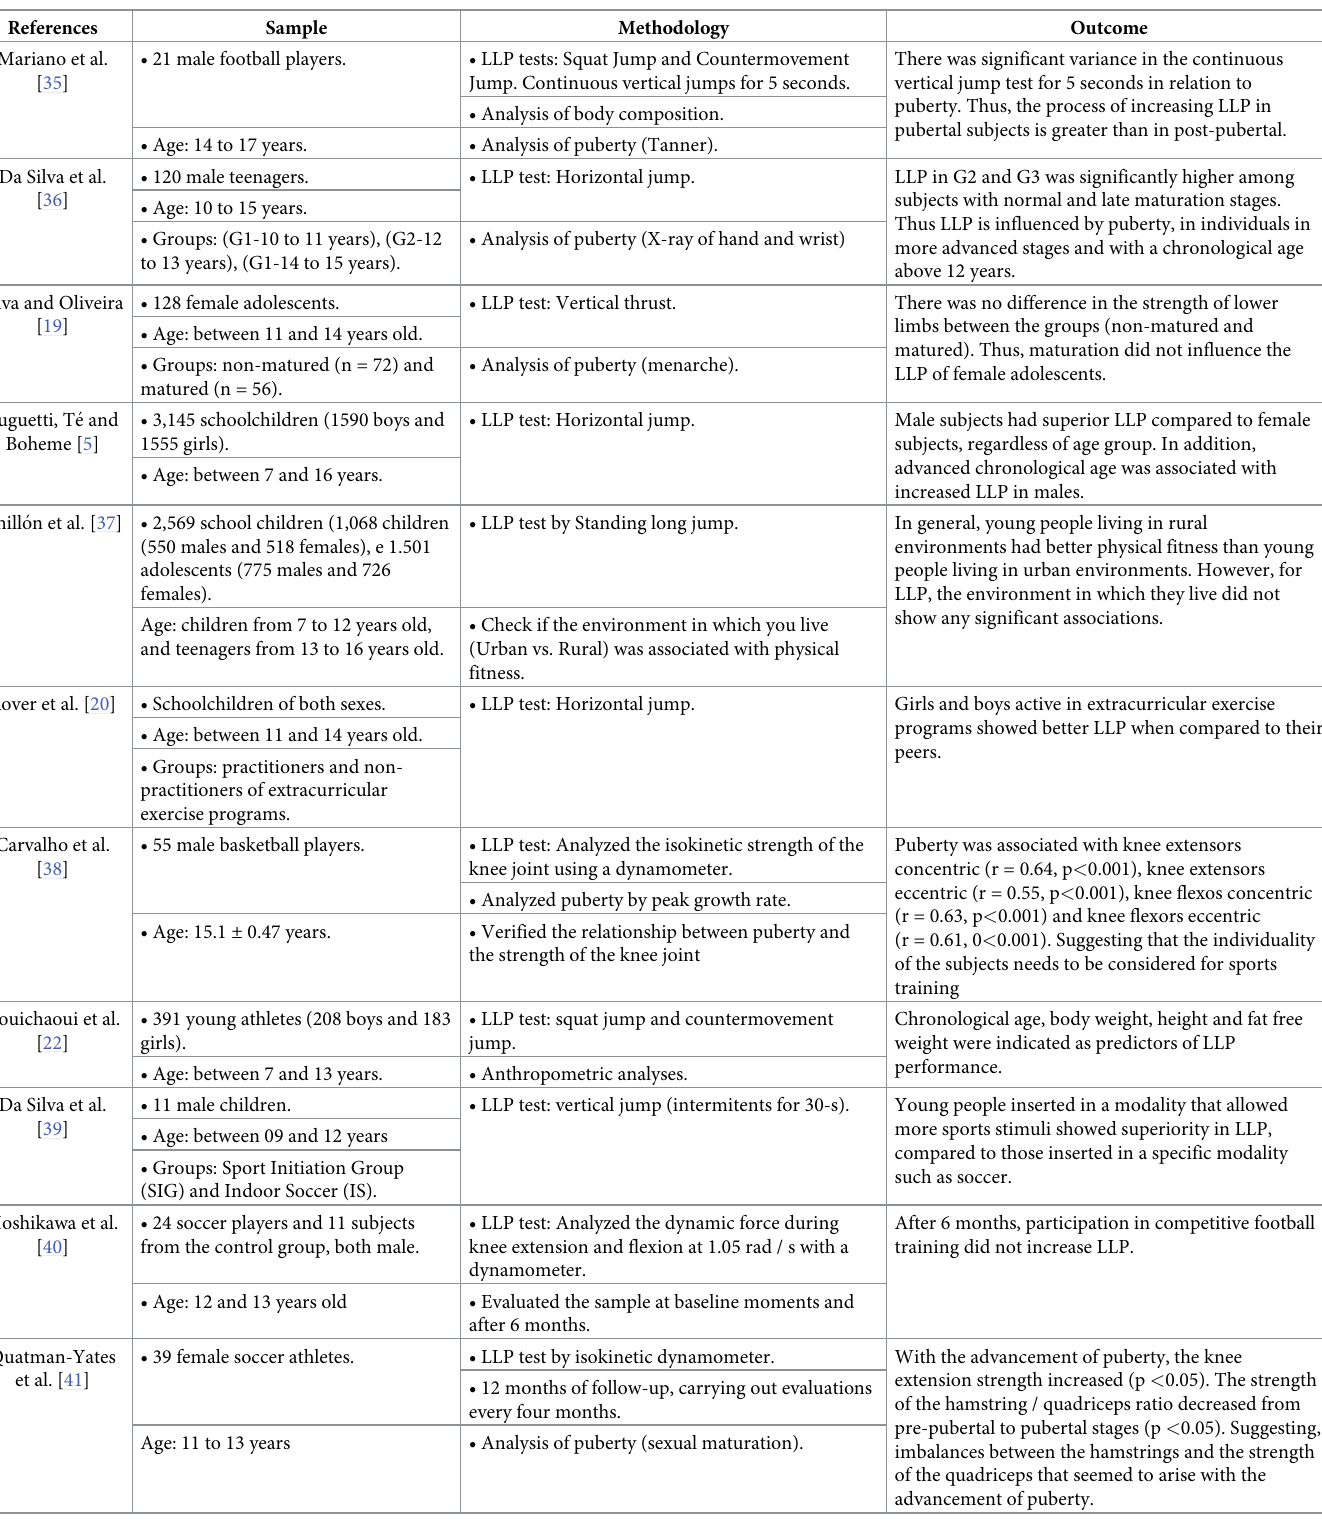
Table 2. Characteristics of the